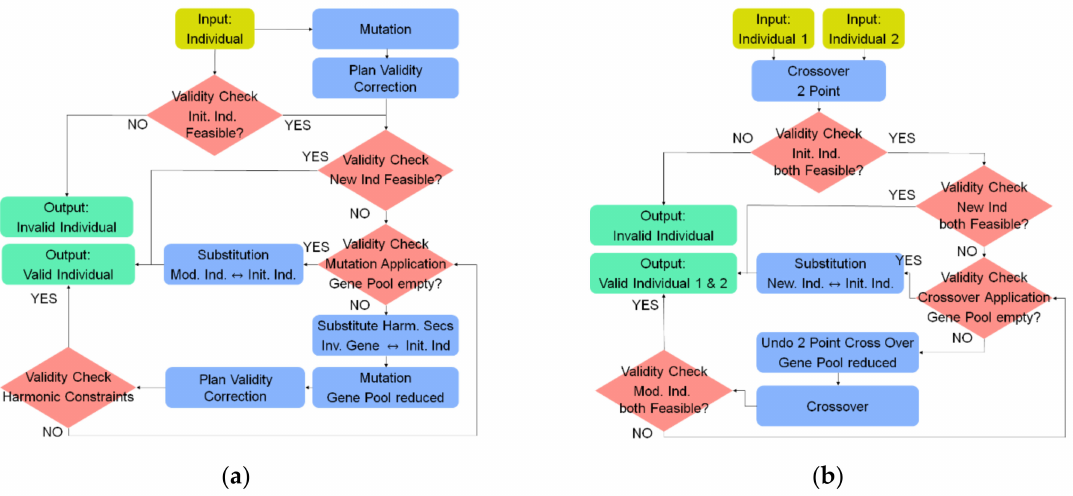
Figure 11. ( a ) Flow chart of the mutation scheme including the validity check and the patch function for plan validity correction. ( b ) Flow chart of the crossover scheme including the validity filter for the two initial and the two modified